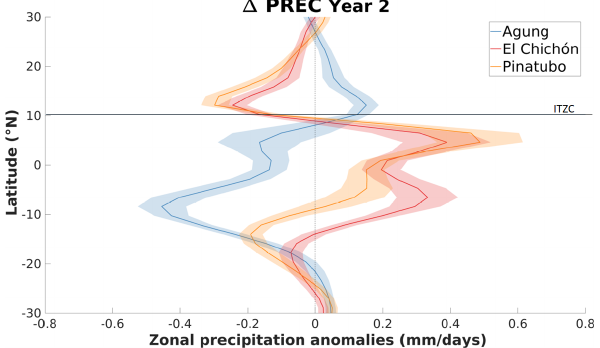
Figure 6. Ensemble mean of the zonal precipitation anomaly over the Pacific Ocean (160 ◦ E–100 ◦ W) between the summer to winter seasons (June to February) of the second year after each eruption and the 3-year climatology. Shading represents twice the standard error of the ensemble mean (i.e. ∼ 95% confidence interval). The horizontal line highlights the ensemble-mean 3-year climatology position of the ITCZ (defined as the location of the zonal-average precipitation maximum).